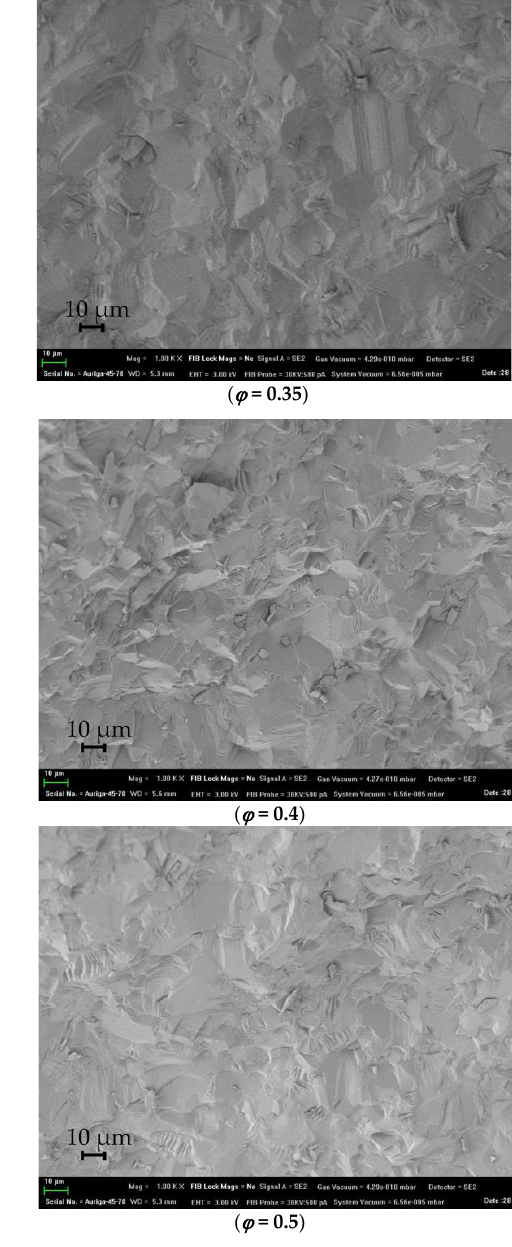
Figure 5. Appearance of the Y 2 O 3 ceramics with different SHS precursor compositions  and 1wt.% LiF sintering additive.